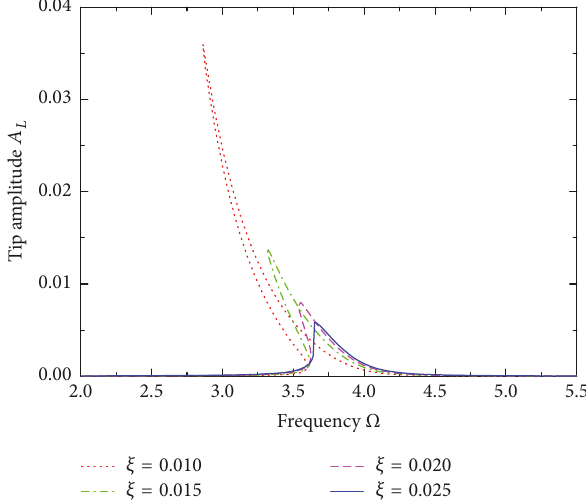
m t = 0 m t = 0.05 Figure 6: Tip amplitude diagram with respect to the variation in tip mass 𝑚 𝑡 for 𝑔 = 0.2 , 𝜉 = 0.01 , 𝑟 0 = 0.0909 , and 𝑛 = 5 .